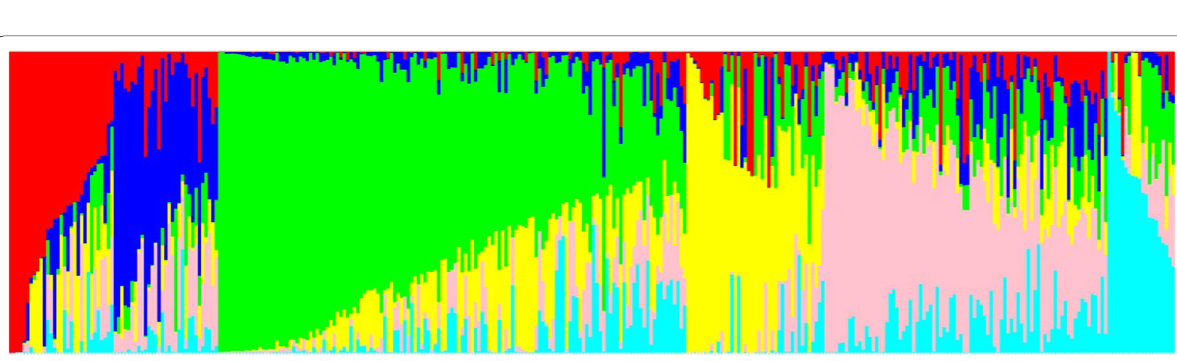
Table 2 AMOVA summary partitioning marker variance into within and between six sub-populations in complete set of O. rufipogon population Variation between sub-populations